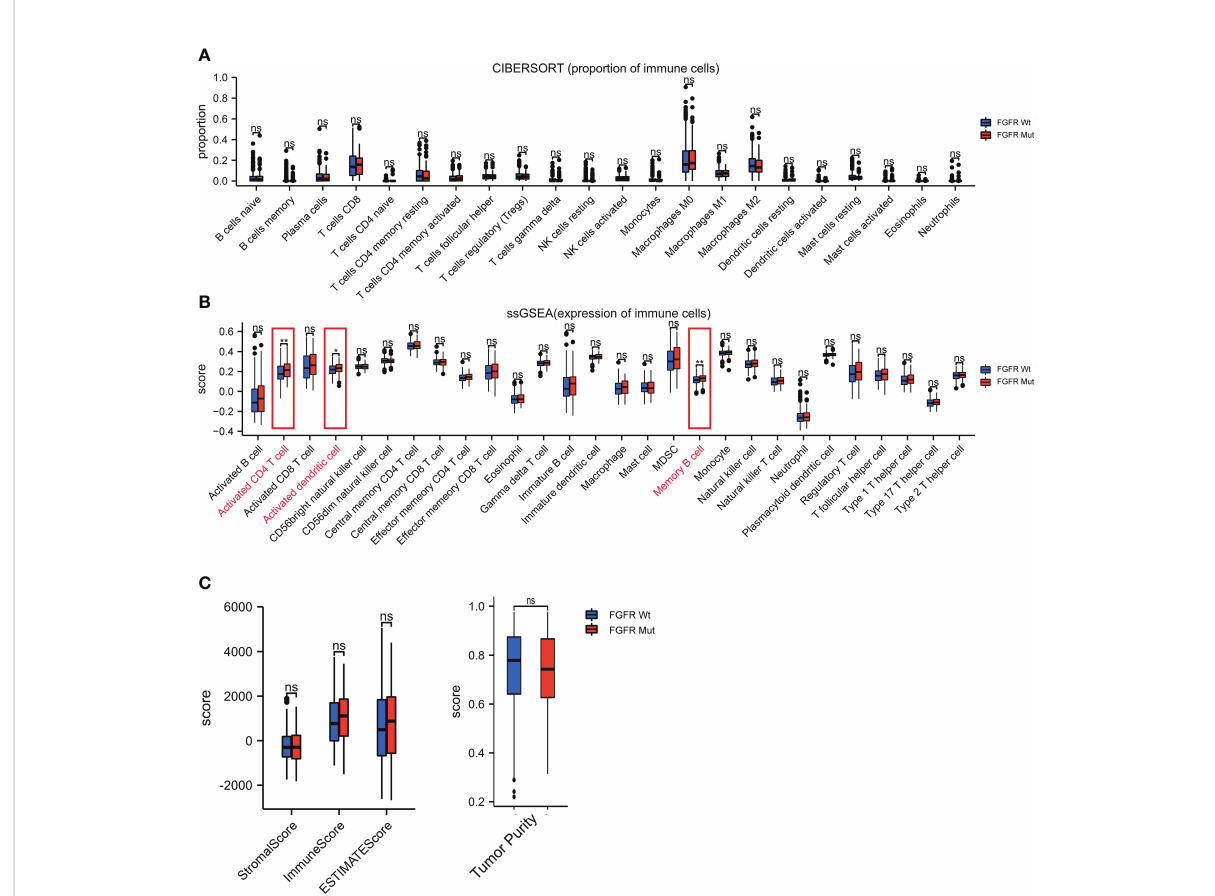
FIGURE 7 Difference of immune cell in fi ltration between FGFR Mut and FGFR Wt melanoma. (A) Comparison of proportion of immune cells between FGFR Mut and FGFR Wt melanoma. (B) Comparison of expression of immune cells between FGFR Mut and FGFR Wt melanoma. (C) Comparison of immune-related score between FGFR Mut and FGFR Wt melanoma (ns = not signi fi cant, *P < 0.05, **P <